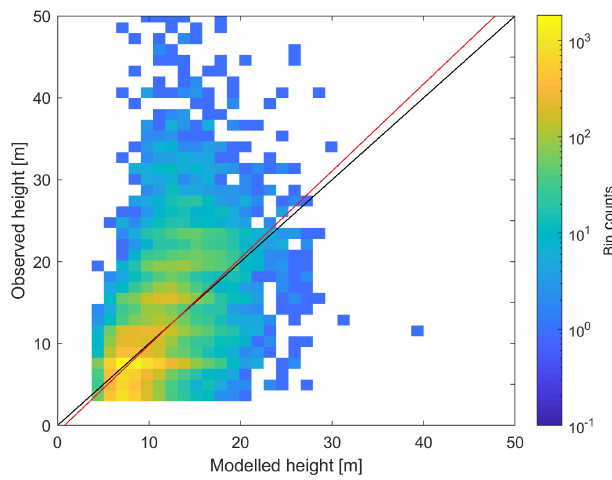
Figure 3. Binned scatter plot for observed and modelled heights of residential buildings for 30 European capitals, out-of-sample vali- dation. The black line is the 1:1 line, and the red line is the linear regression